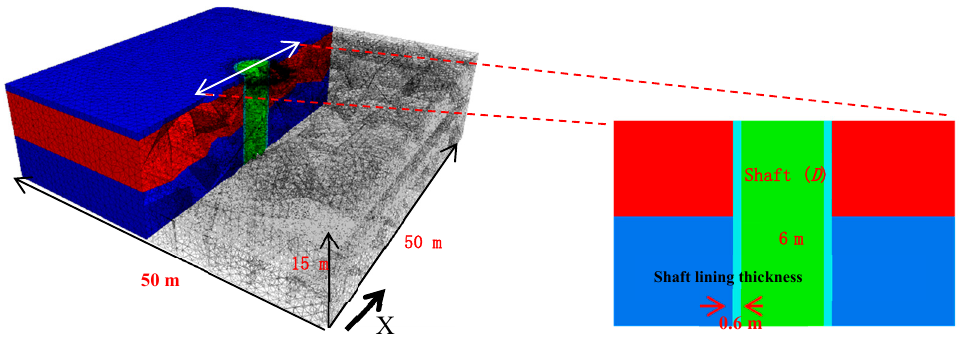
Figure 8. Numerical model for the surrounding rock of the shaft.